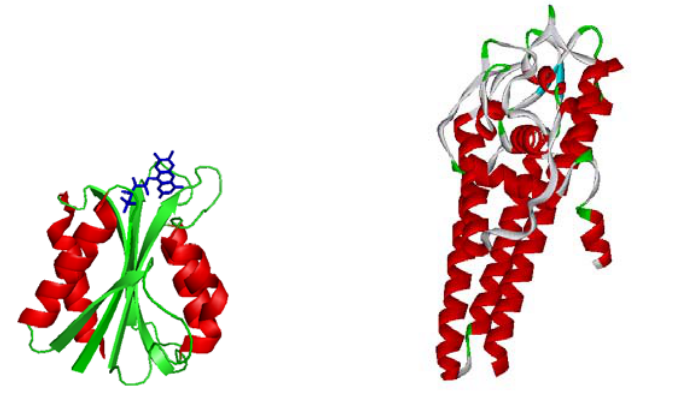
Figure 1. Cartoon structures of flavodoxin (left) and VlsE (right) indicating secondary structure motifs (using crystal structures). The cofactor, FMN, in flavodoxin is shown in stick (but removed in experiments presented